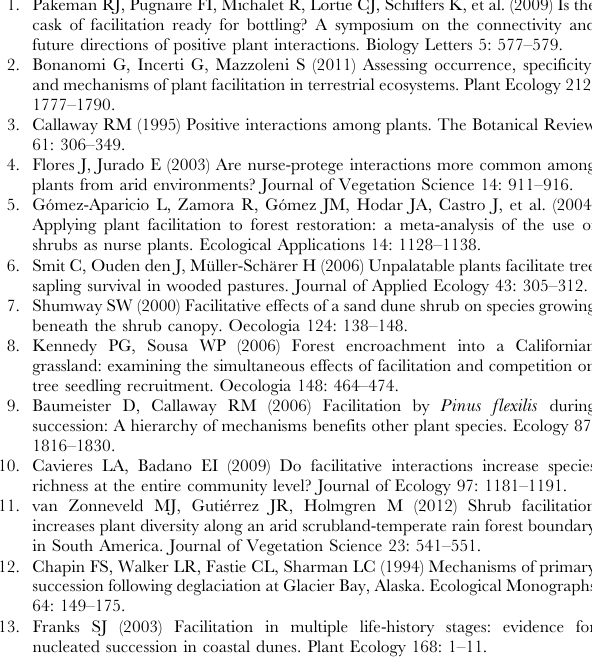
Table S2 Results of the model selection for soil